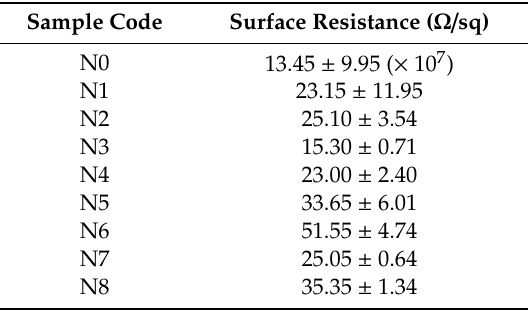
Table 5. Surface resistance of Cu / Ni-coated Milife fabric.